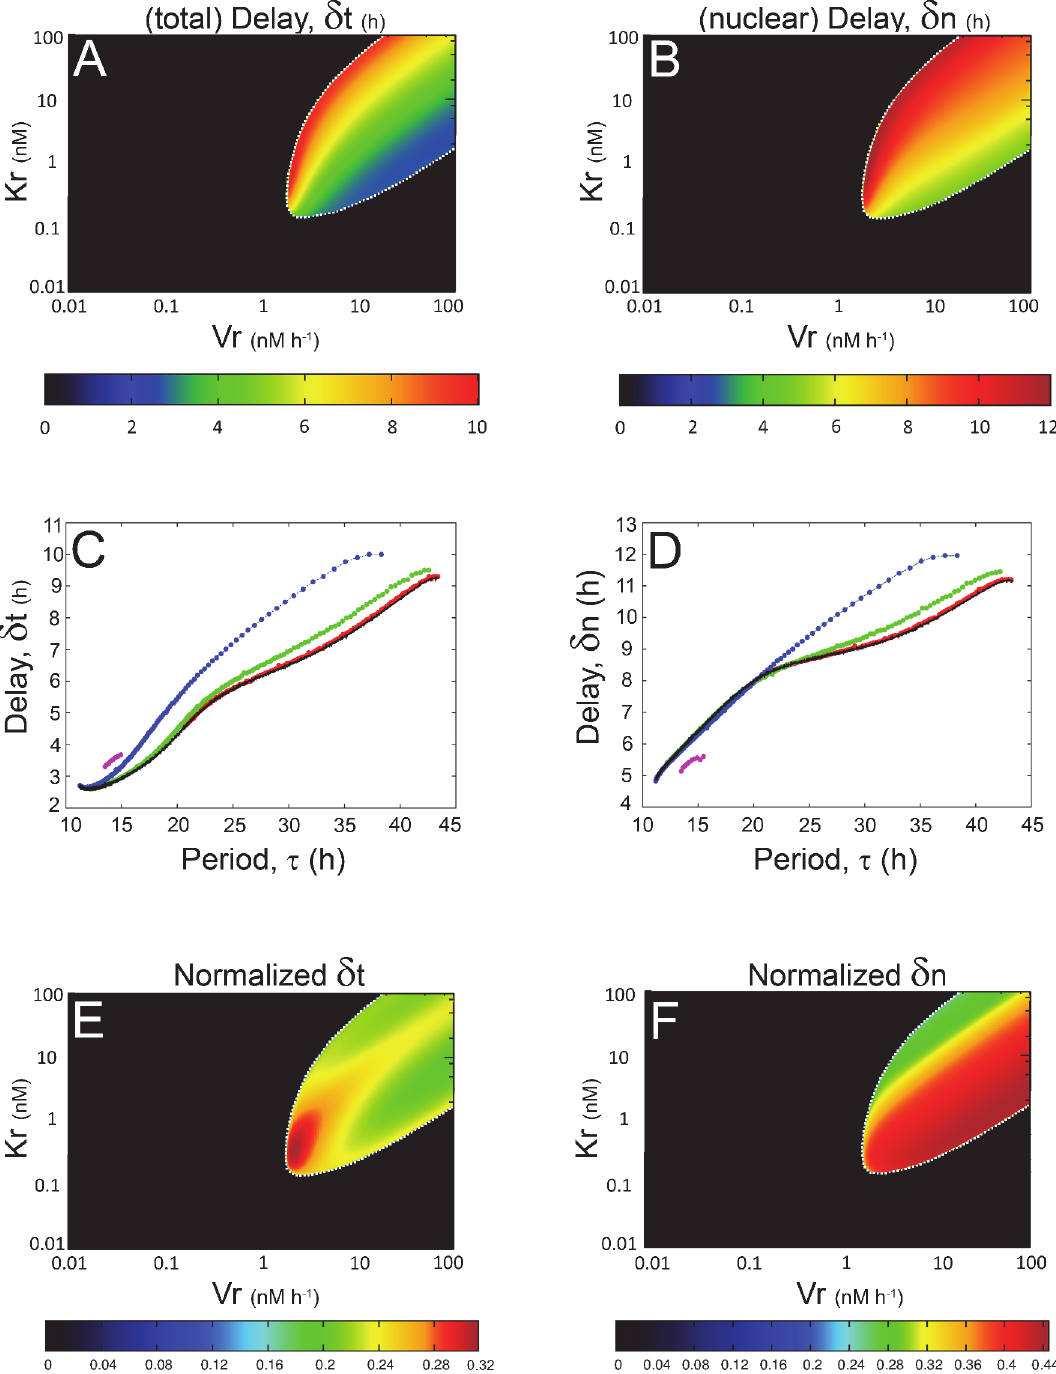
Figure 5. Analysis of the delays when PER translation is achieved by a single kinetic mechanism. Total delay ( A ) and nuclear delay ( B ) diagrams within the V r - K r parameter subspace, for a cooperative model in which k s = 0 h − 1 . Total delay profile ( C ) and nuclear delay profile ( D ) diagrams as functions of the period τ . Each color line represents a fixed value of K r , as follows: red = 100 nM ; green = 10 nM ; blue = 1 nM and magenta = 0.14 nM . For a better comparison we have included the profile δ t versus τ for the model with a translational process achieved only by the R -independent mechanism ( V r = K r = 0), which follows a first-order kinetics (black line). All these curves increase monotonically as τ increases. Figs. 5 E and F represent, respectively, the normalized total delay and nuclear delay diagrams within the K r - V r -subspace. The color key for each K r - V r -diagram is shown at the bottom of each plot. In those diagrams a white dotted line was added in order to emphasize the transition between the two dynamical behaviors observed in our